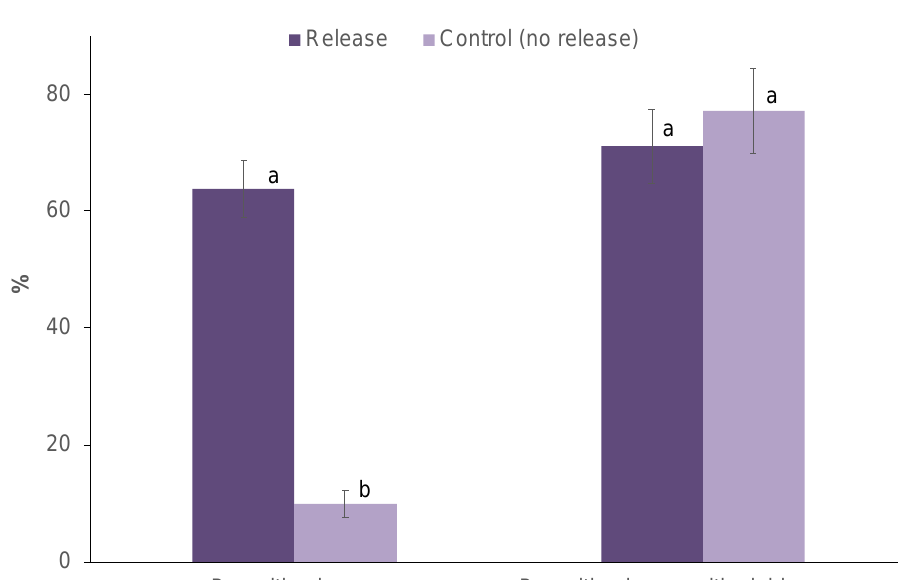
Figure 3. Parasitized eggs of Spodoptera frugiperda (% ± S.E.) in release and control fields following on-station augmentative releases of T. remus and corresponding emerging progenies (% ± S.E.). For each parameter, treatments bearing different letters were significantly different (Bonferroni test, α = 0.05).